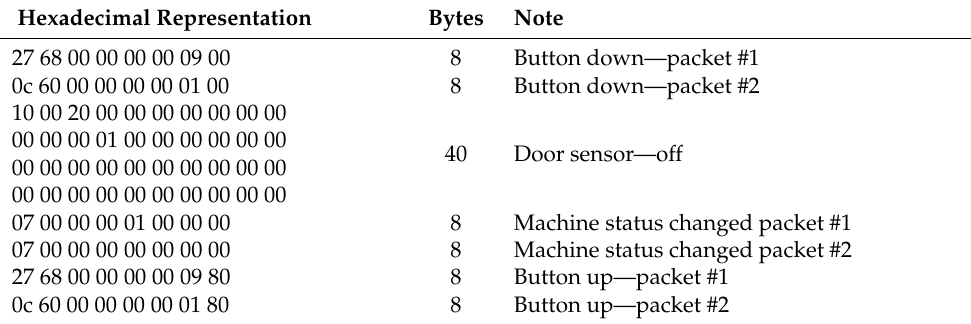
Table 1. Hexadecimal representation of the door open button event. Hexadecimal Representation Bytes Note